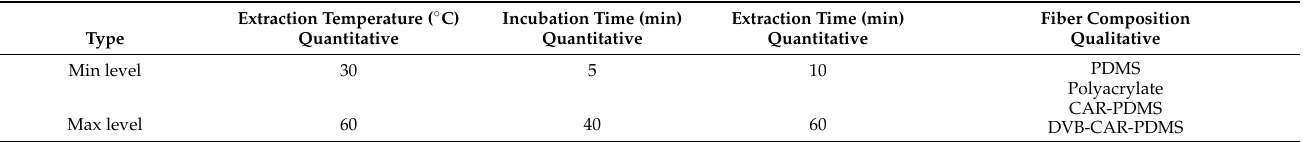
Table 5. List of factors considered in the experimental design applied in the HS-SPME method